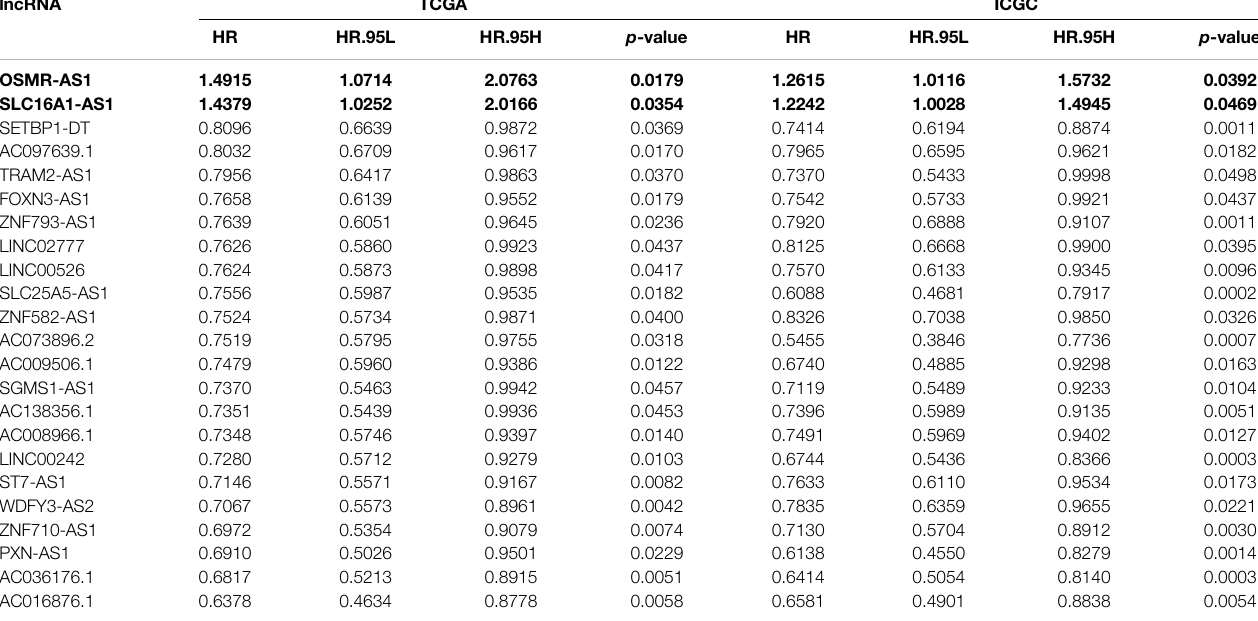
TABLE 1 | The 23 ferroptosis-related prognostic